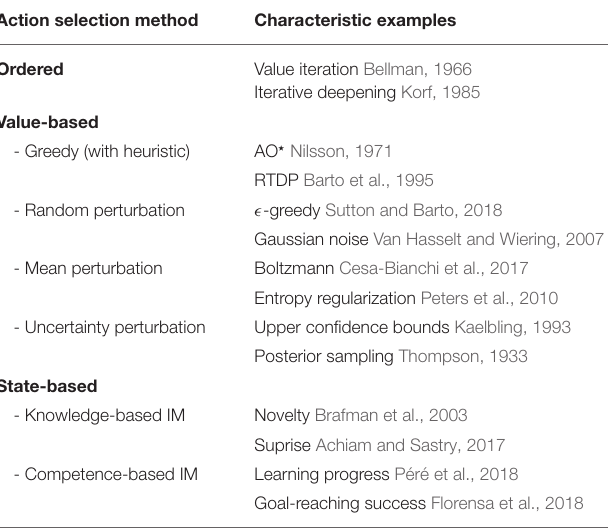
TABLE 4 | Overview of action selection methodology within a trial. Action selection method